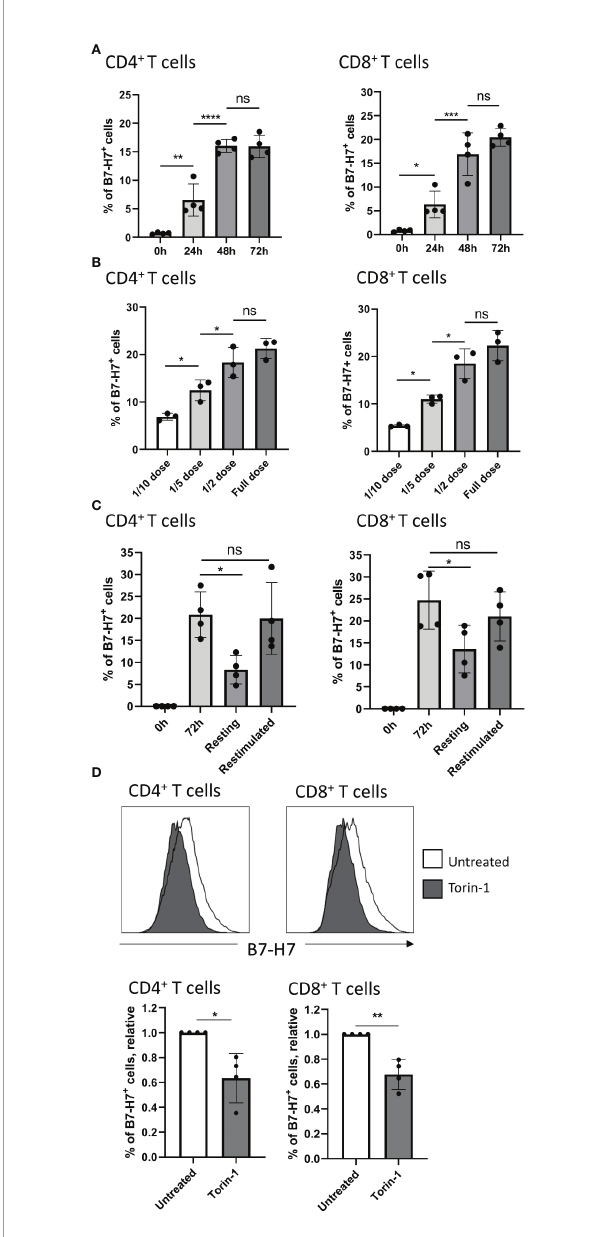
FIGURE 3 | Expression of B7-H7 is dynamic and dependent on mTOR activity. (A) B7-H7 expression on CD4+ and CD8+ T cells at 24, 48, or 72 hours, n=4. (B) Expression of B7-H7 at different dilutions of TransAct ™ . Full dose of TransAct ™ is 1:100 dilution, n=3. (C) B7-H7 expression in activated, resting and re-stimulated T cells. Puri fi ed T cells were activated with the recommended dose of TransAct ™ (1:100) for 72 hours, washed and reseeded in fresh medium containing 100 IU/ml of IL-2 ( ‘ resting ’ ) or fresh medium containing the standard dose of TransAct ™ for another 72 hours ( ‘ restimulated ’ ), n=4. (D) Relative expression of B7-H7 in TransAct ™ (1:100) activated T cells in the presence or absence of the mTOR inhibitor Torin-1 (1nM) or untreated control, n=4. Cells were gated for live and single cells.